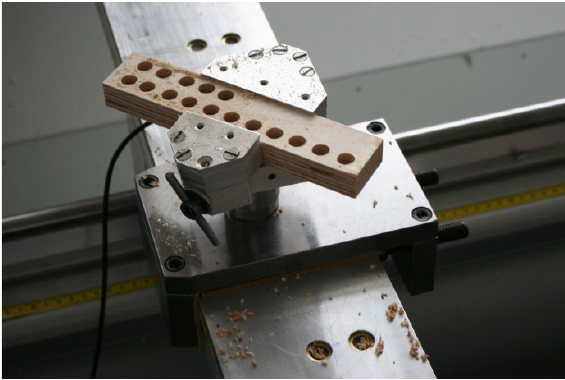
Figure 4. Scheme of the system used for measuring and digital recording of 5 selected signals generated during drilling: feed force, drilling torque, noise, ultrasonic acoustic emission (AE), and acceleration of jig vibration [35].